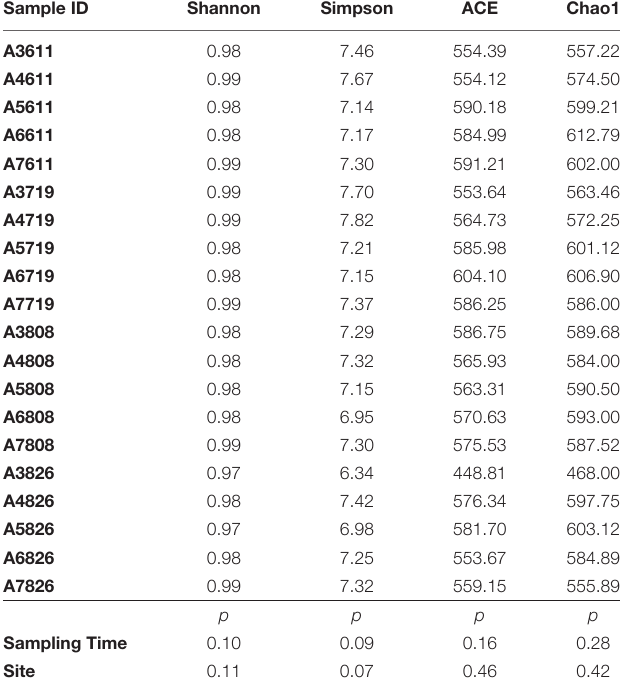
TABLE 1 | Alpha diversity index of 16S